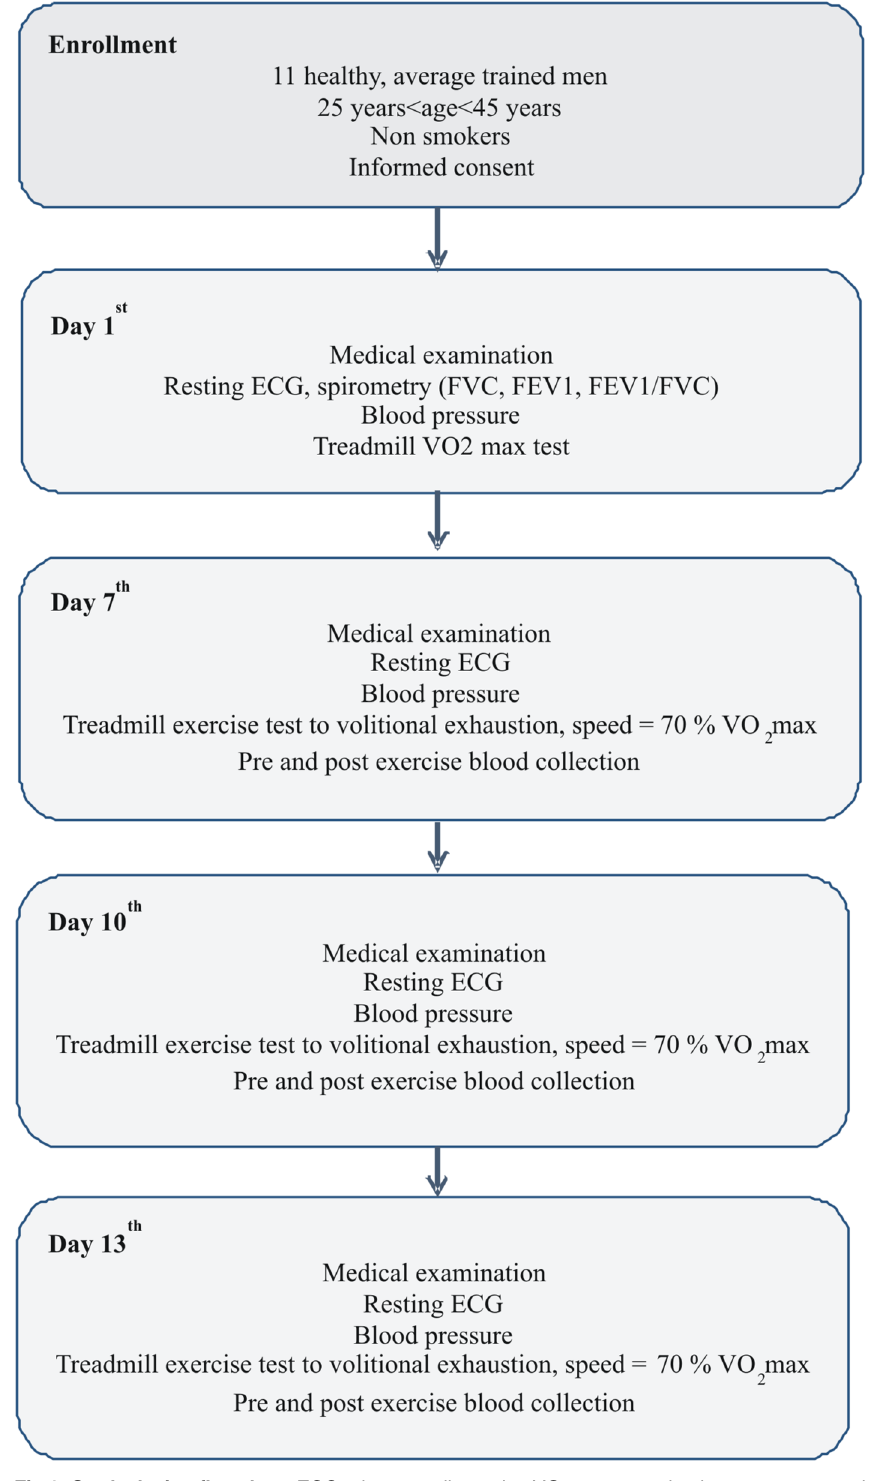
Fig 1. Study design flowchart. ECG -electrocardiography, VO 2 max—maximal oxygen consumption, FVC —forced vital capacity, FEV 1 —forced exhaledvolume in the first second. Duringthe wholestudy period (13 days), volunteersdid not perform any exhaustiveexercise besidesthose related to the study protocol.